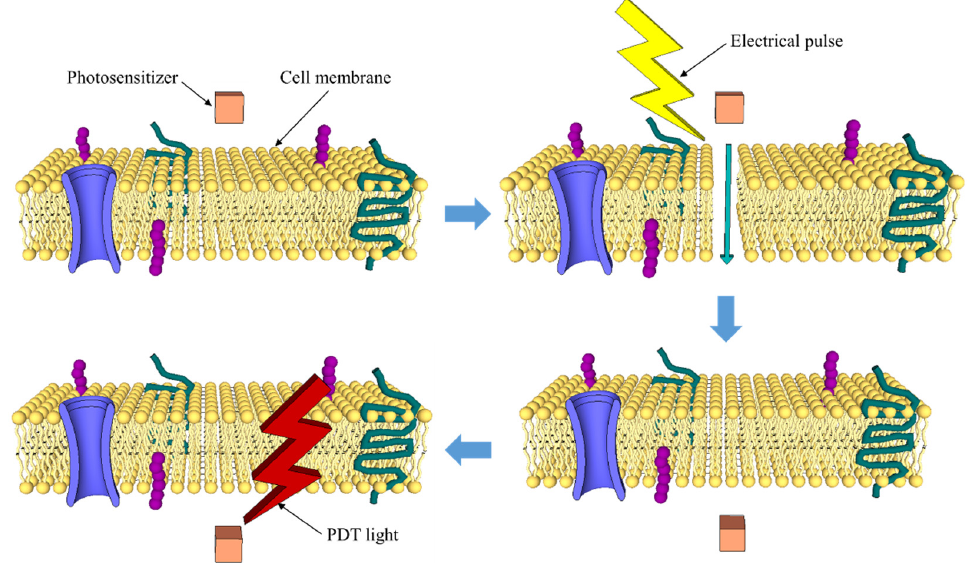
Figure 4. PDT with electroporation (based on